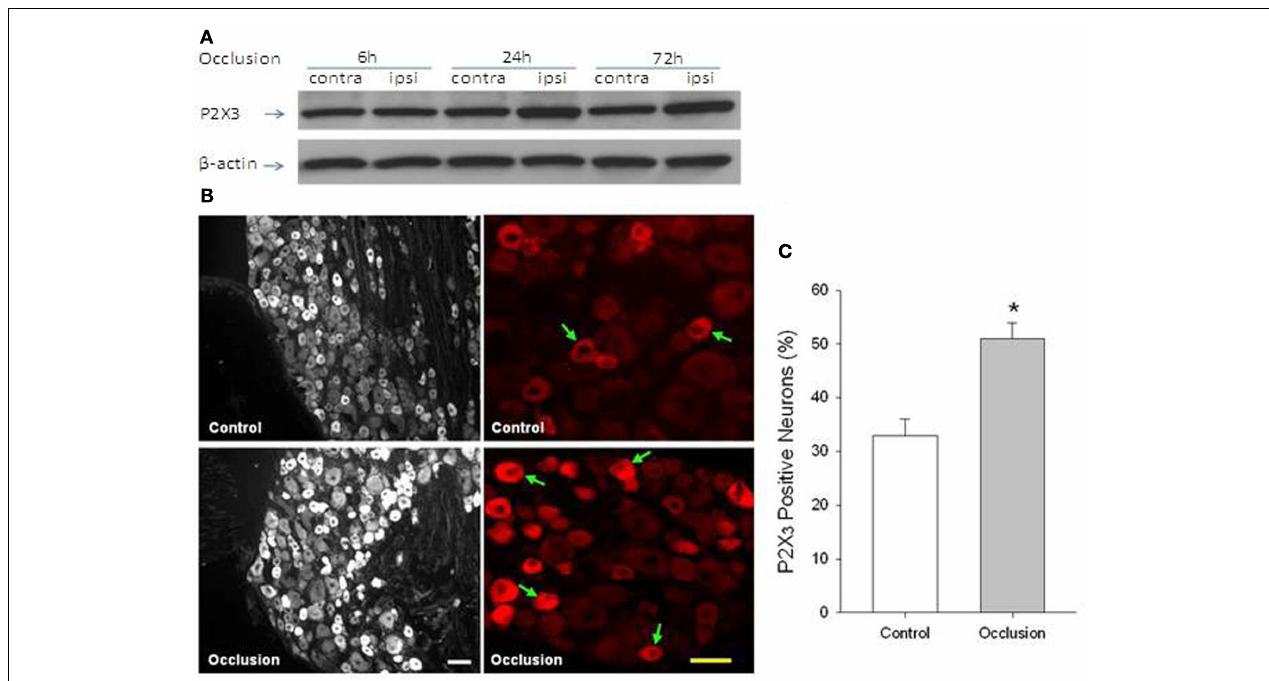
loading. (B,C) Fluorescence immunohistochemistry was employed to examine expression of P2X3 in DRG neurons of control limb and occluded limb. Representative photomicrographs and average data show that P2X3 appears within lumbar DRG neurons and that percentage of P2X3 positive neurons is greater in DRG neurons of 24h of femoral artery occlusion ( n = 6) than that in control ( n = 6). Arrows indicate P2X3 positive cells. Scale bar = 50 µ M. * P < 0.05, compared with control. Reprinted from Liu et al.